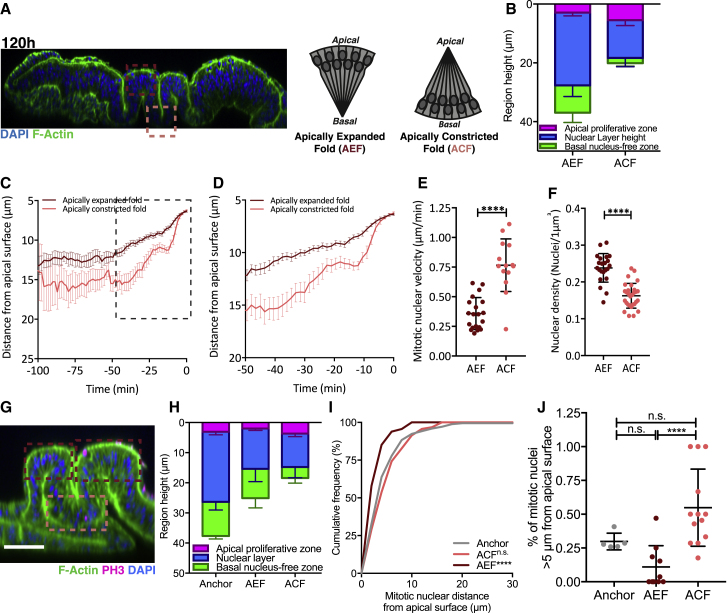
Tissue Folding Influences Mitotic Nuclear Positioning and Dynamics(A) Cross-section of 120 h wing disc stained with DAPI (blue) and phalloidin (green), and schematic of epithelial topology in fold regions. Dark-red box, apically expanded fold; peach box, apically constricted fold.(B) Epithelial apico-basal morphology for fold regions in wing discs expressing Sqh-GFP and His-RFP.(C and D) Average mitotic nuclear track with directed apical movement for fold regions in wing discs expressing Sqh-GFP and His-RFP. Enlarged in inset (D). All tracks presented in Figures S4D and S4E.(E) Mitotic nuclear velocity for the AEF and ACF for fold regions in wing discs expressing Sqh-GFP and His-RFP. The mean onset of upward movement was −14.8 and −11.1 min and the duration of upward movement was 10.8 and 6.9 min, respectively. n = 14 (AEF) and 20 (ACF) nuclear trajectories from 3 wing discs per condition.(F) Nuclear density for fold regions in wing discs expressing Sqh-GFP and His-RFP. n = 3 wing discs.(G) Representative image of mechanically buckled 120 h AEL wing disc. Folds marked as in (A). Scale bar, 10 μm.(H) Epithelial apico-basal morphology for mechanically buckled regions.(I) Cumulative frequency distribution of mitotic nuclear distance for mechanically buckled regions. Corresponding data in Figures S4G–S4I.(J) Percentage of mitotic nuclei more than 5 μm from apical surface for mechanically buckled regions. n = 5 (anchored), 10 (AEF), and 13 (ACF).Data for anchored discs also presented in Figures 3J–3N. Statistical significance: (E) and (F), unpaired t test (with Welch’s correction in E); (I), Kolmogorov-Smirnov comparison of cumulative distribution; (J), one-way ANOVA. n.s., p > 0.05; ∗∗∗∗p < 0.0001. Error bars: (C) and (D), mean ± SEM; (E), (F), (H), and (I), mean ± SD.